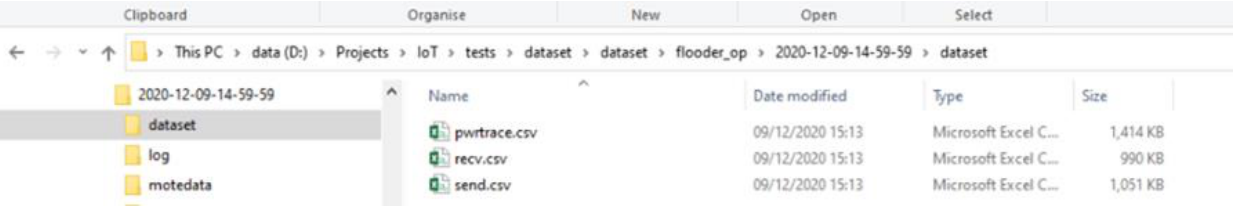
Figure 27. Location of the generated “pwrtrace.csv”, “recv.csv”, and “send.csv” files by the “IoT_Simul.sh” bash file .